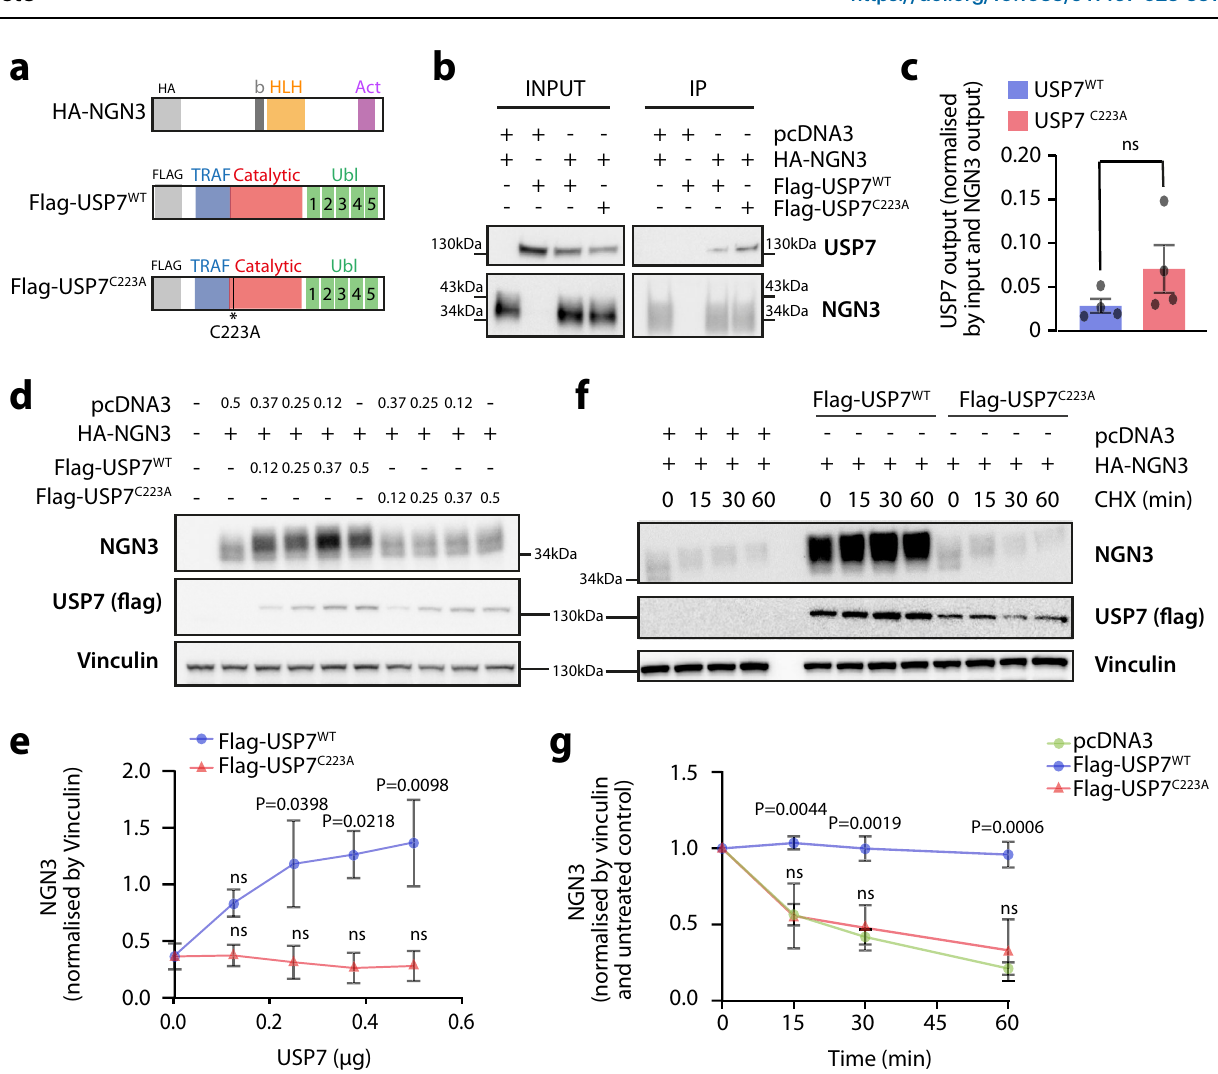
ANOVAwithDunnett ’